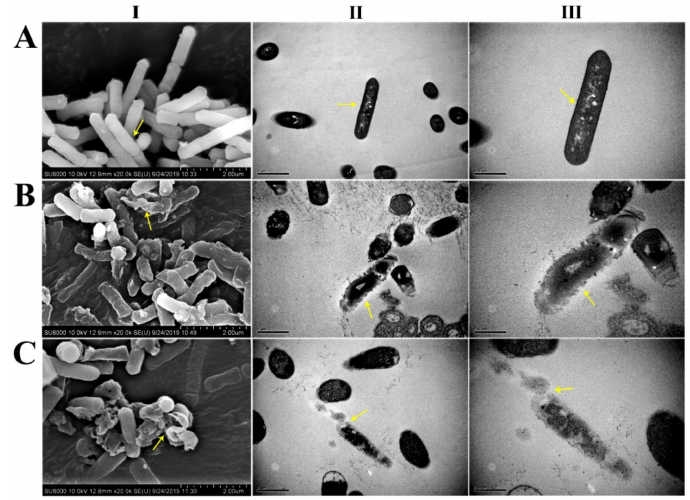
Figure 10. Cell membrane damage of X. oryzae pv. oryzae cells treated with two antimicrobial peptides (OrR214 and OrR935) at their MICs. Before the samples were coated with gold, glutaraldehyde was used for freeze-drying. ( A - I ) PBS, ( B - I ) OrR214, and ( C - I ) OrR935 were examined under the scanning electron microscope. ( A - II ) PBS, ( B - II ) OrR214, and ( C - II ) OrR935 were examined at 1 µ m resolution under the transmission electron microscope. ( A - III ) PBS, ( B - III ) OrR214, and ( C - III ) OrR935 were examined at 0.5 µ m resolution under the transmission electron microscope. Treatment with PBS was used as a control. The yellow arrows indicate major di ff erences in di ff erent